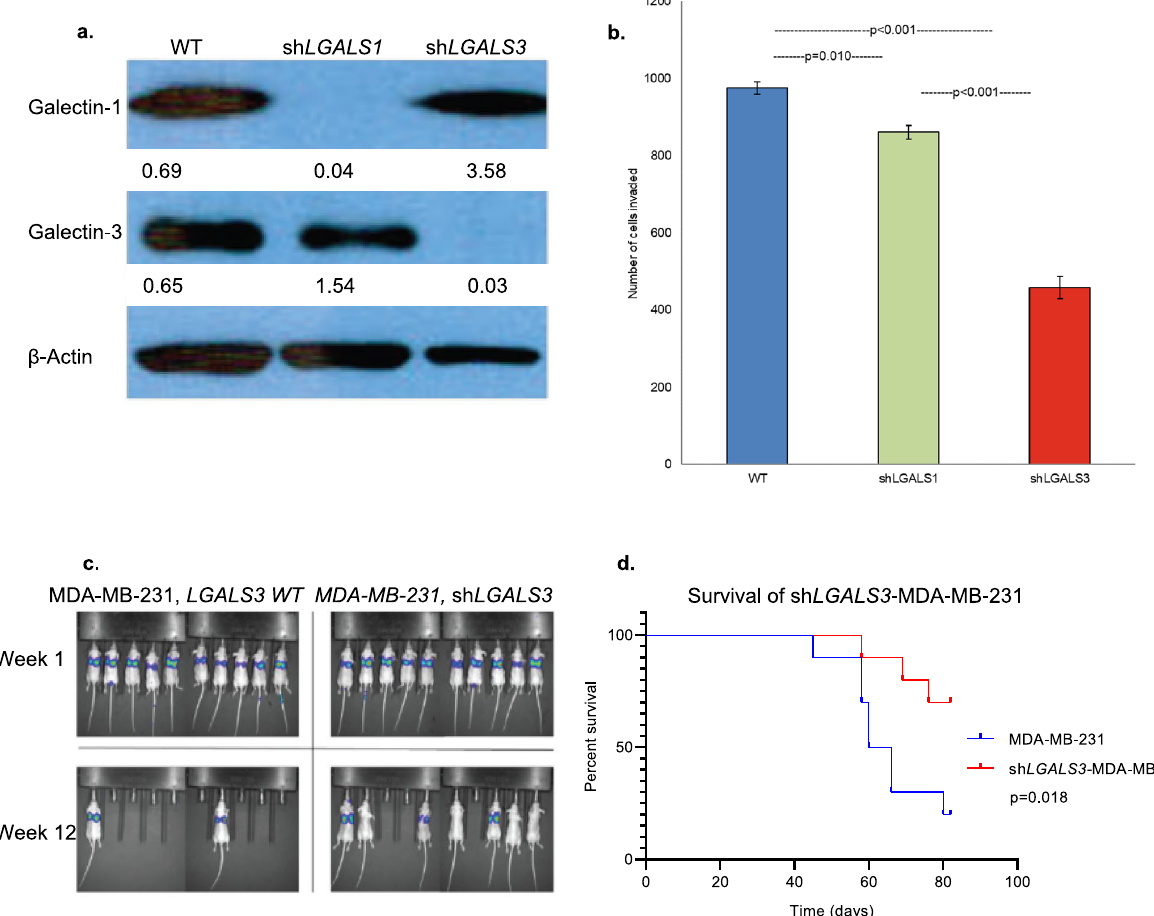
Figure 2. Knockdown sh LGALS3- MDA-MB-231 cells show decreased invasiveness both in vitro and in vivo . ( a ) LGALS3 knockdown cell line, sh LGALS3 -MDA-MB-231 and a similar LGALS1 knockdown, sh LGALS1 - MDA-MB-231 were generated. LGALS3 and LGALS1 silencing was confirmed by Western blot in a manner previously described 23 . β-Actin normalized densitometry quantification values are shown below each Western blot band. ( b ) In a Matrigel assay using triplicate chambers with 1 × 10 4 cells/chamber, invasion of the sh LGALS3 -MDA-MB-231 and sh LGALS1 -MDA-MB-231 were compared to the parental MDA-MB-231 wild-type cell line after 48 h ( p = 0.005, unpaired t test; error bars represent standard error). Three replicates were performed. ( c ) Representative luminescence images of all mice inoculated intravenously (by tail vein) with 5 × 10 6 sh LGALS3 -MDA-MB-231 cells or wild-type MDA-MB-231 control cells as previously described 31 . ( d ) Kaplan–Meier survival curves; median survival for mice (n = 10 female athymic nude mice) implanted with MDA-MB-231 wild-type cells was 60 days (95% CI, 53.8–66.2), while median survival for mice (n = 10 female athymic nude mice) implanted with shLGALS3-MDA-MB-231 cells was not reached ( p = 0.02, log-rank 14D11). The antibody isotype is an IgG 1 with κ light chain. The 14D11 antibody bound to human and mouse Gal3, and Peptide 1, but not to human galectin-1, 7, 8, or 9 (Fig. 3C). The binding constant of 14D11 to Gal3 was evaluated by surface plasmon resonance (SPR) 34 . The 14D11 and 22417a.1D1.E12 (1D1) antibodies were bound to an anti-mouse Fc surface and recombinant human Gal3 protein delivered across a variety of concentrations (Fig. S2A). The 14D11 dissociation constant (K D ), as measured by SPR, was 14.6 nM (Fig. S2B).